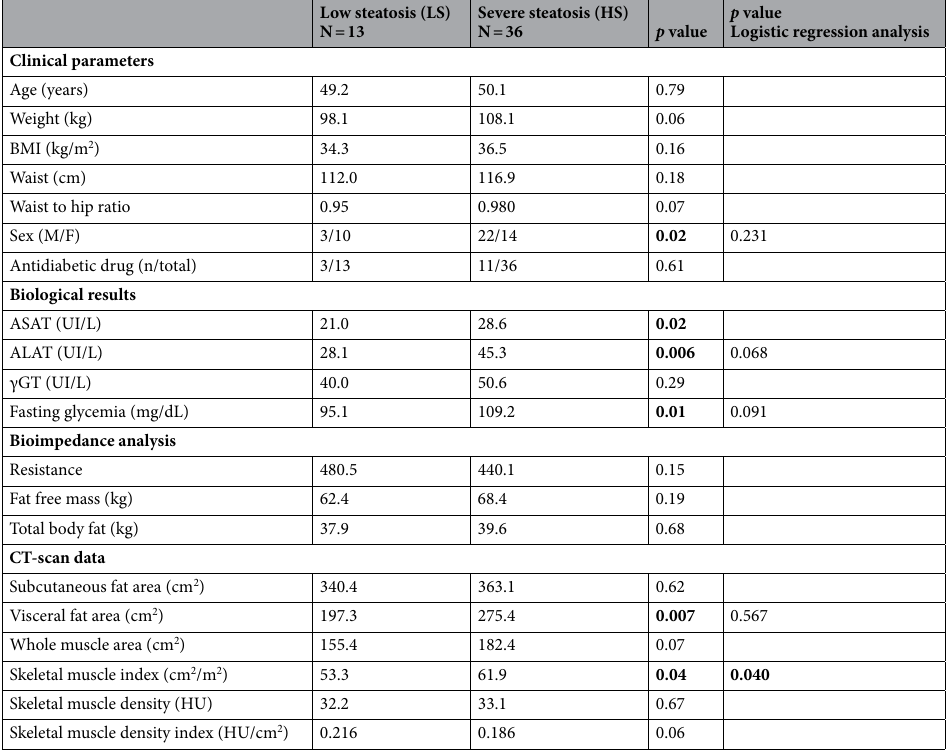
Table 3. Analysis of patients with severe steatosis. Results are given as mean value (and compared with a bilateral Student-t-test). Number of patients are compared with a chi-squared test. All significant parameters from the univariate analysis (except for collinear values) included in the logistic regression analysis are reported in the last column. ASAT aspartate aminotransferase, ALAT alanine aminotransferase, BMI body mass index, γGT γ-glutamyl transferase, HU Hounsfield unit. Significant differences are presented in